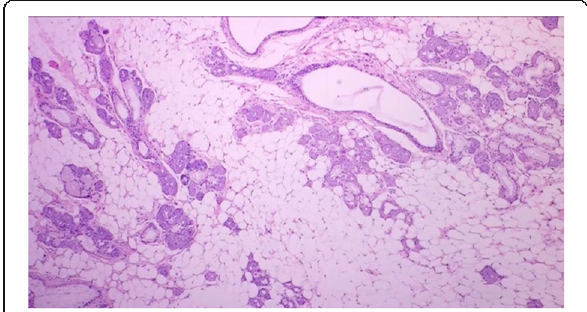
Fig. 4 Most of the lesion consists of adipose cells compared to epithelial elements. (H&E. 20X)